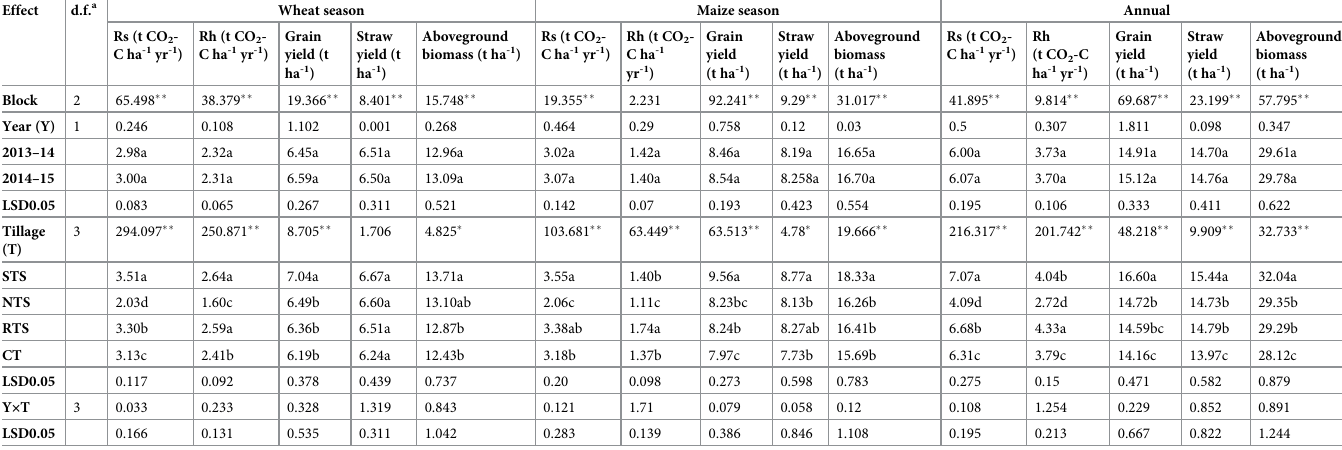
Table 3. ANOVA of total soil respiration (R s ), microbial respiration (R h ), wheat and maize grain yields, straw yields and aboveground biomass during the wheat- and maize- growing seasons during the 2013–2015 rotation. Effect